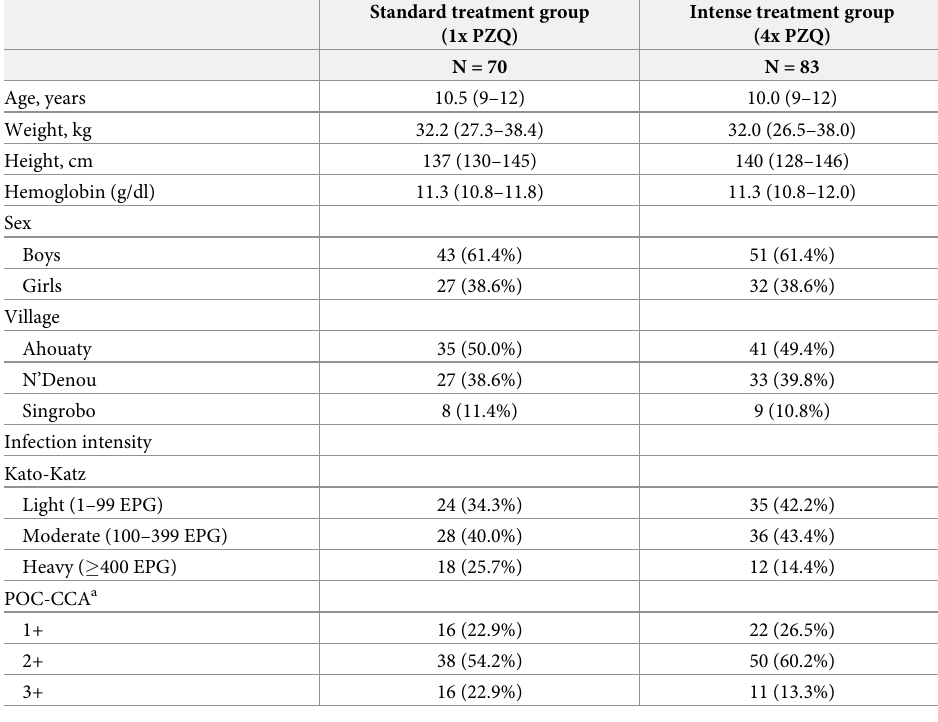
Table 1. Baseline characteristics of the standard treatment group and the intense treatment group in a random- ized trial. The trial was conducted in late 2018 among school-aged children in south-central Coˆte d’Ivoire and com- pared single versus four repeated PZQ treatments against S . mansoni